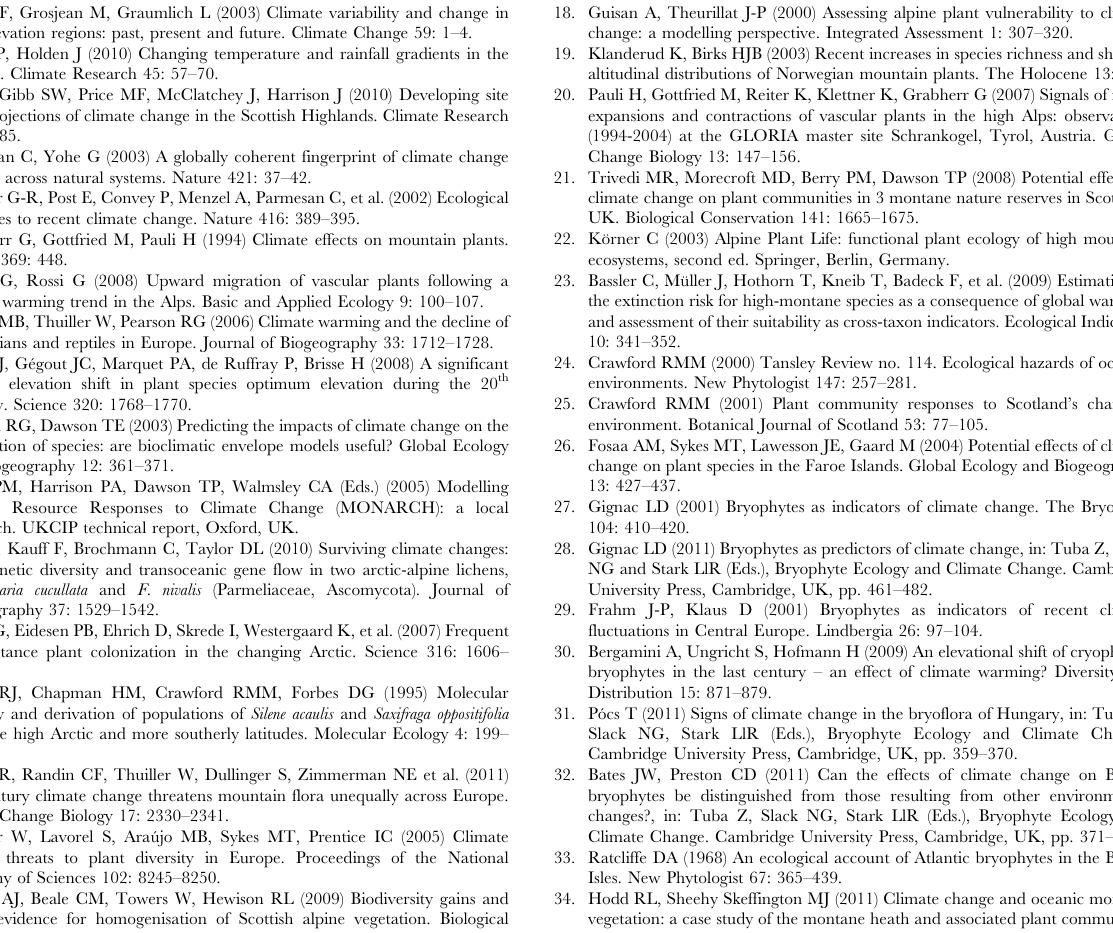
Table S7 Outputs from gap analysis, showing the proportional overlap of both current and future distri- bution of all species with protected areas, using a range